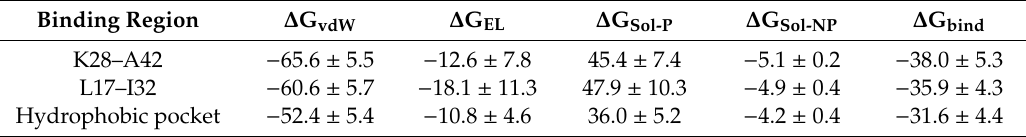
Figure 6. Iododoxorubicin binding to ( a – d ) 2MXU and ( e , f ) 5OQV fibril structures. Superposition of iododoxorubicin coordinates (center of mass) during the 2MXU MD simulations ( a , b ) and snapshots of the main binding regions ( c , d ). Superposition of IDOX coordinates during the 5OQV MD simulation ( d ) and a snapshot of the main binding area ( f ). Table 2. Iododoxorubicin–A β fibrils (2MXU) binding energy from MM-PBSA. Δ G EL indicates the electrostatic interaction energy, Δ G vdW the van der Waals interaction, Δ G Sol-P the polar contribution to the solvation energy, Δ G Sol-NP the non-polar contribution to the solvation energy, and Δ G bind the total binding energy. All values are in kcal/mol.